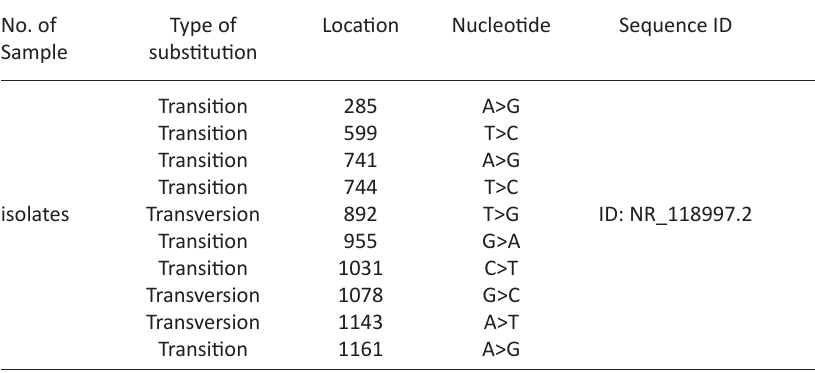
Table 1. Represent type of polymorphism of 16S rRNA gene from Staphylococcus aureus